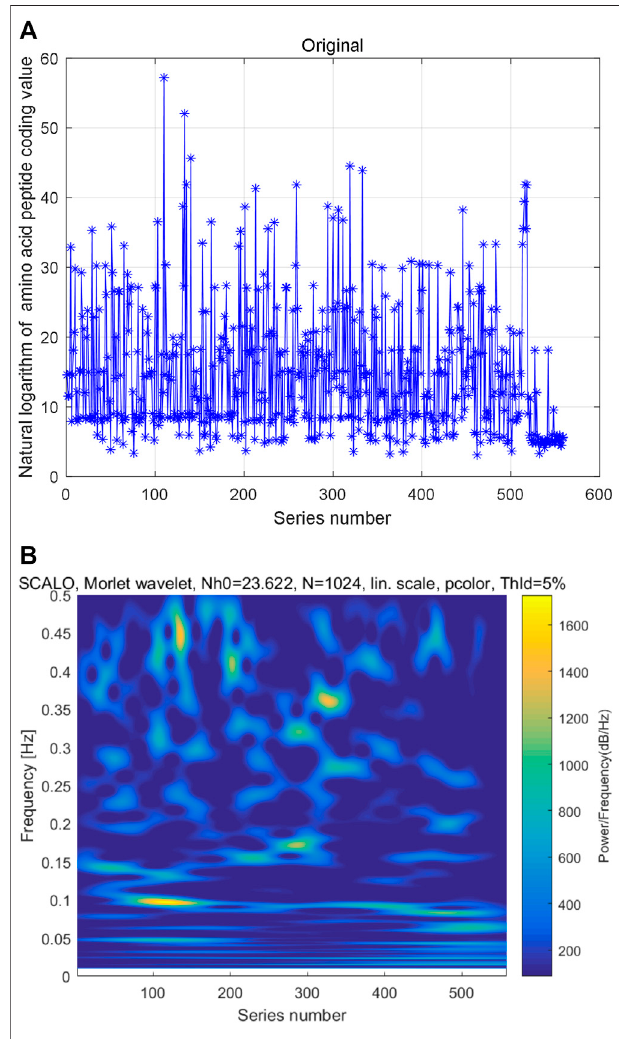
FIGURE 3 | Constructed fi rst time series and its multi-scale wavelet transform: (A) time series of natural logarithm of AHTPA-EC 50 and (B) time – frequency distribution of multi-scale wavelet transform.